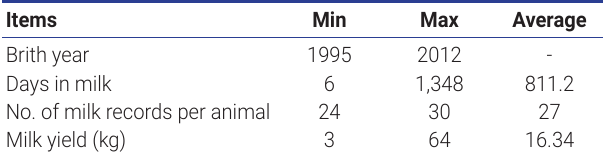
Table 1. Description of primary dataset